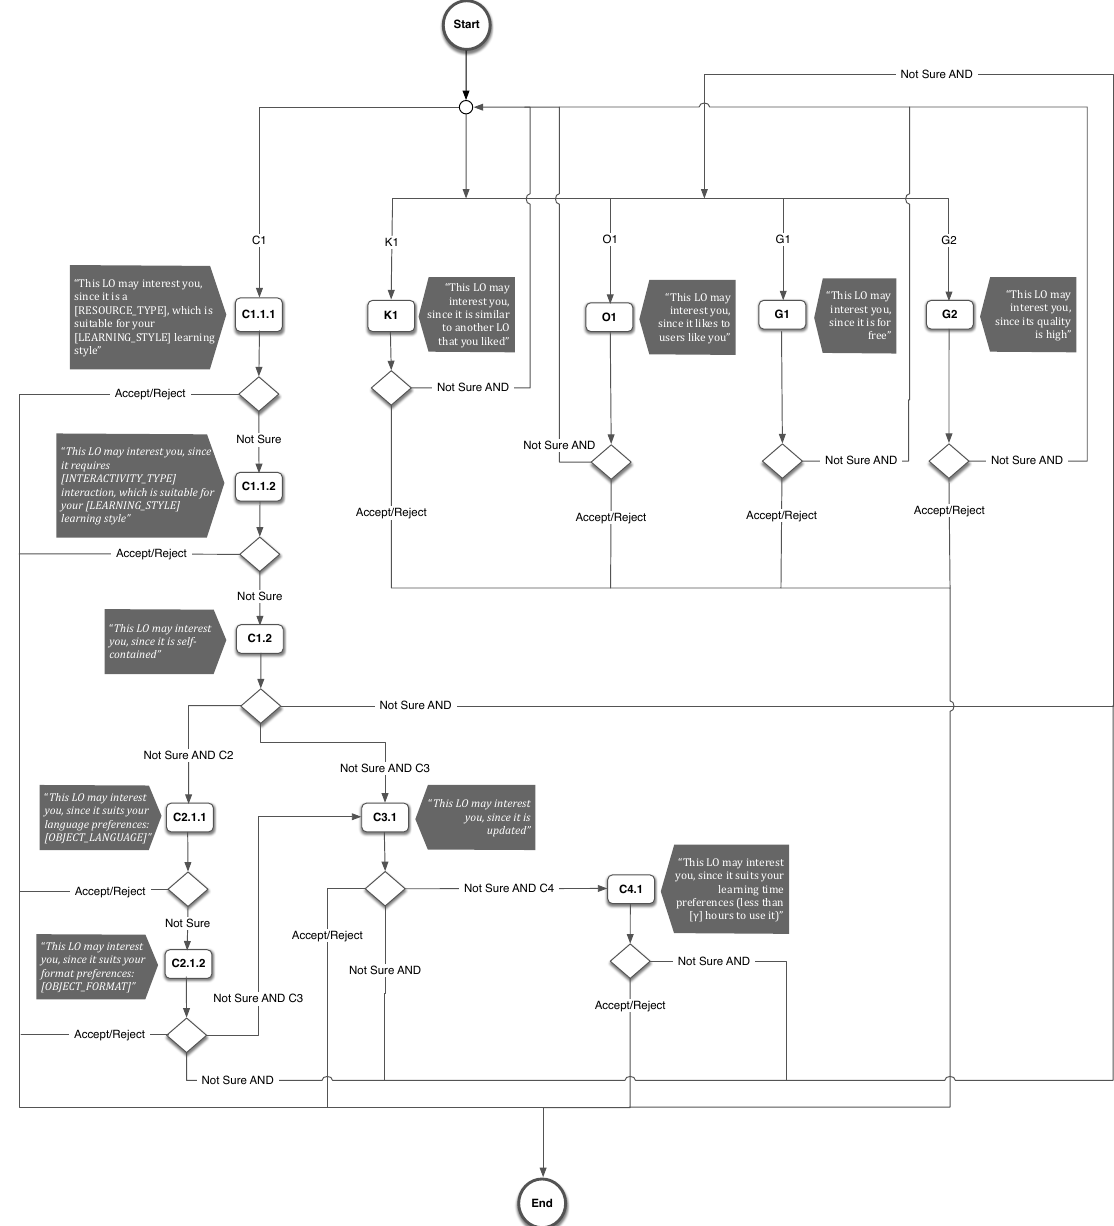
Figure 1. Steps of the conversational dialogue between the C-ERS and the